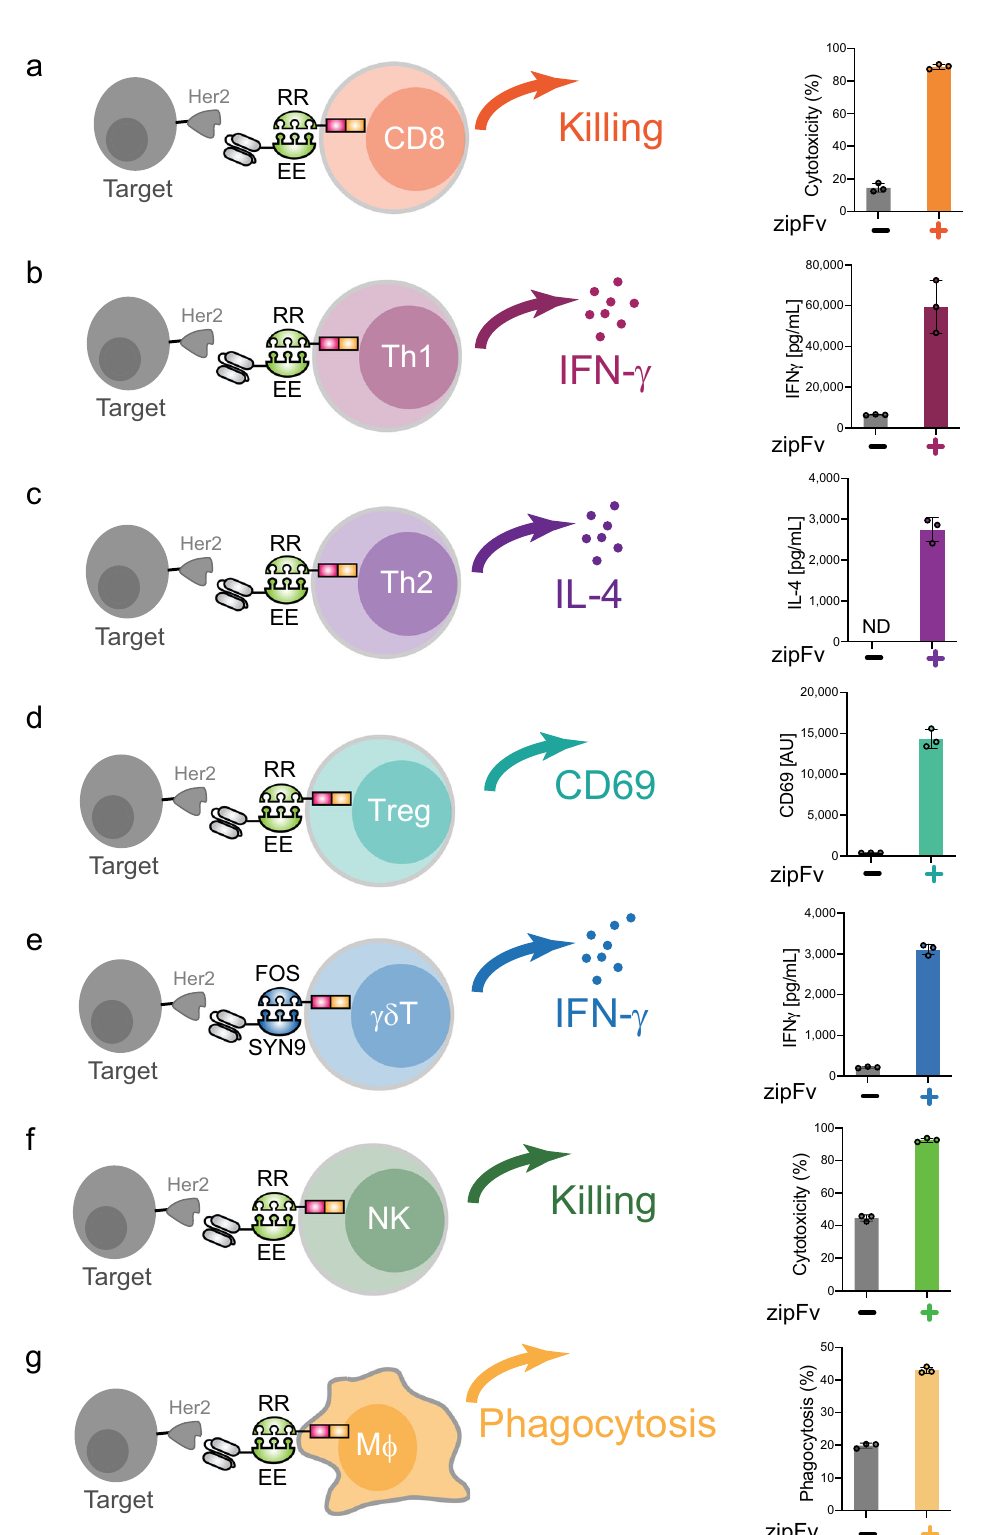
secreted IFN- γ after activation by the administration of the corresponding zipFv (Fig.1e, Supplementary Fig.1d and 1e). NK cells are another type of lymphoid cells that are known to mediate anticancer effects without the risk of inducing GvHD 16 . NK-92, an established NK cell line, is also under investigation for adoptive immunotherapy applications and has demonstrated to be safe in phase I clinical trials 17 – 19 . We utilized